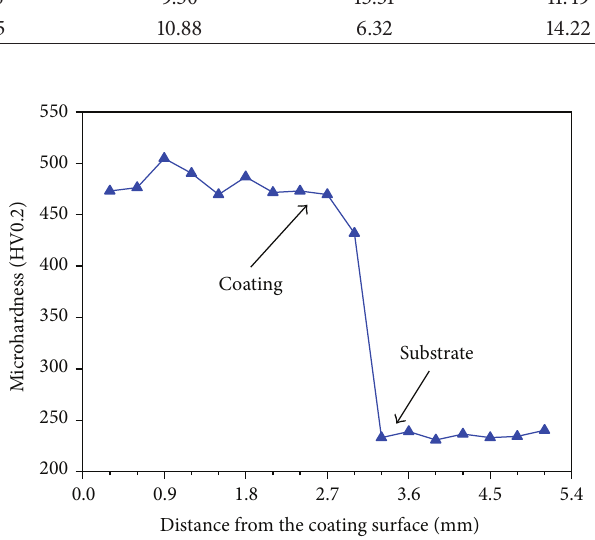
Figure 4: Microhardness profile of CoCrFeMnNbNi HEA coating.